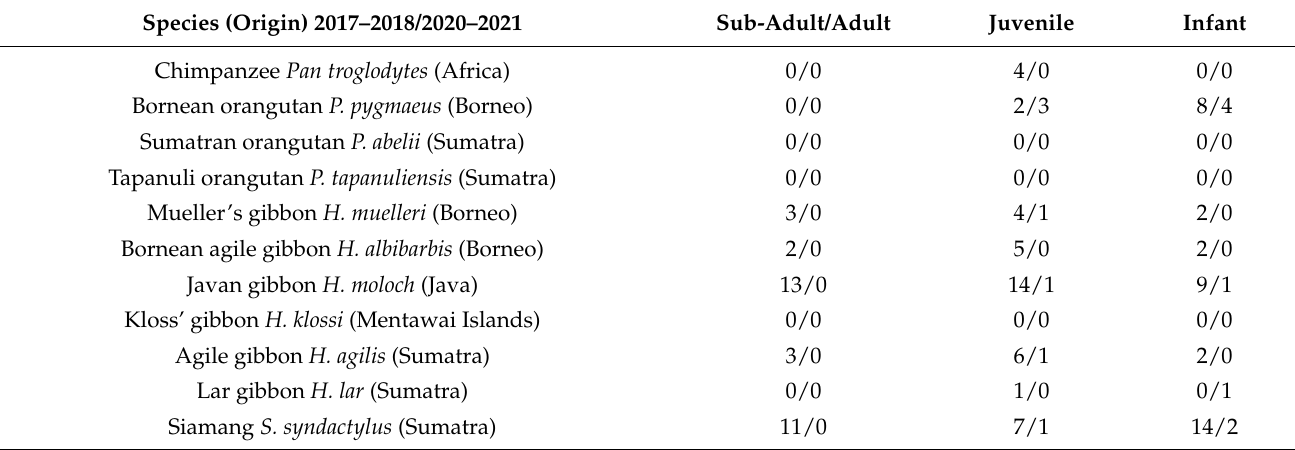
Table 3. Gibbons ( Hylobates and Symphalangus ), orangutans ( Pongo ) and chimpanzees offered for sale in January 2017–April 2018 on five Facebook pages and 19 Instagram accounts and the numbers for sale on these same (or linked) pages